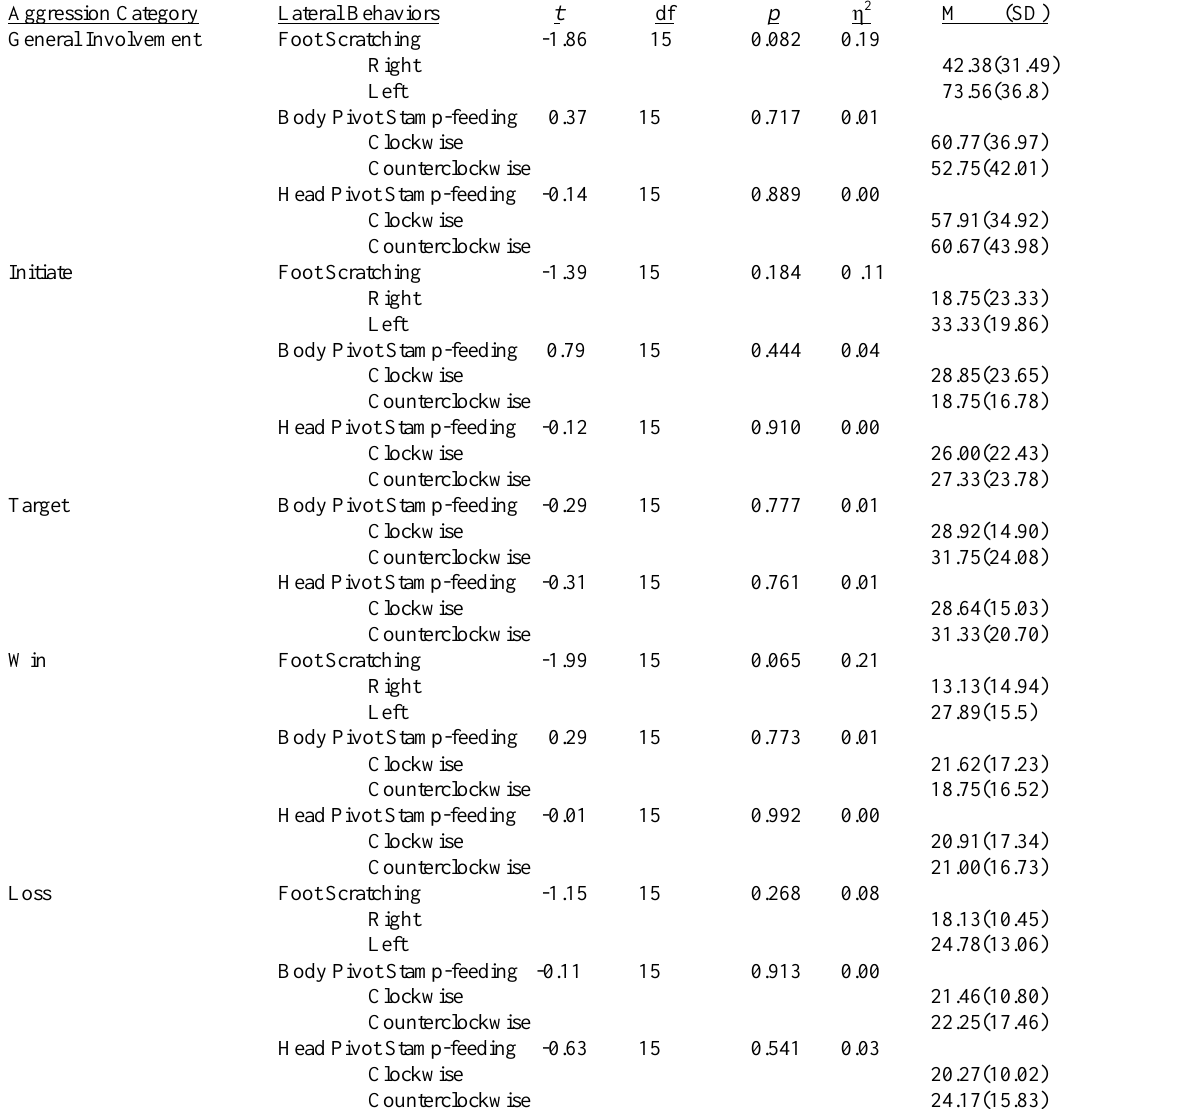
Aggression Categories and Lateral Behaviors Aggression